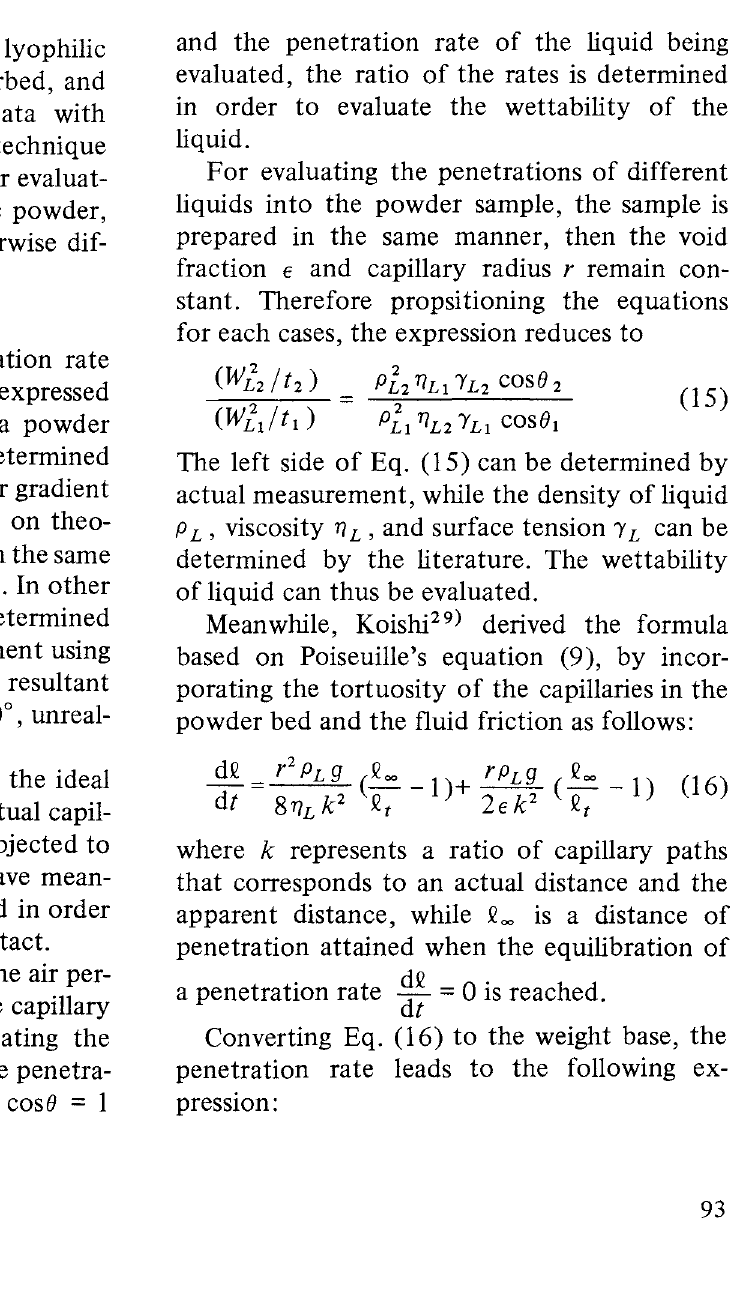
Fig. 12 Some examples of the penetration rate with Ti0